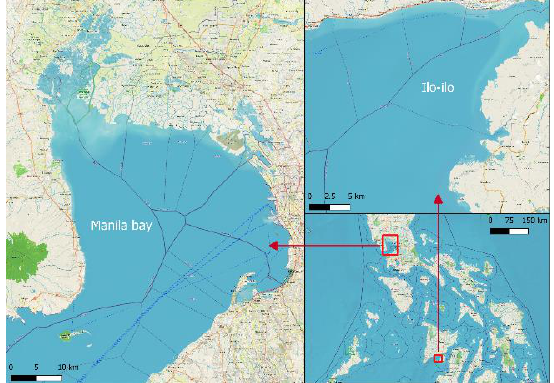
Figure 1 . Location map of Manila Bay (left) and Iloilo Straight (top right). Source: OpenStreetMap